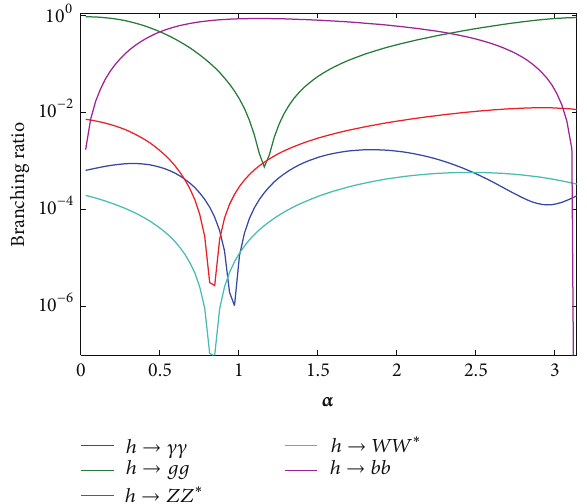
Figure 22: The relevant branching ratios of ℎ in the 4G2HDMI, as a function of 𝛼 , with 𝑚 ℎ = 125 GeV, 𝑀 4𝐺 = 400 GeV, 𝜖 𝑡 = 0.5 , and tan 𝛽 = 1 . Figure taken from